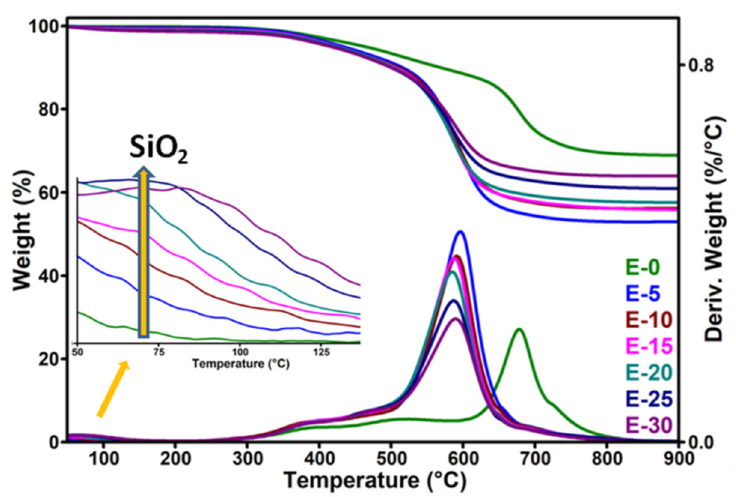
Figure 9. Thermogravimetric and derivative curves of nanocomposites; the detail shows the DTG curves in the range 50–125 °C.